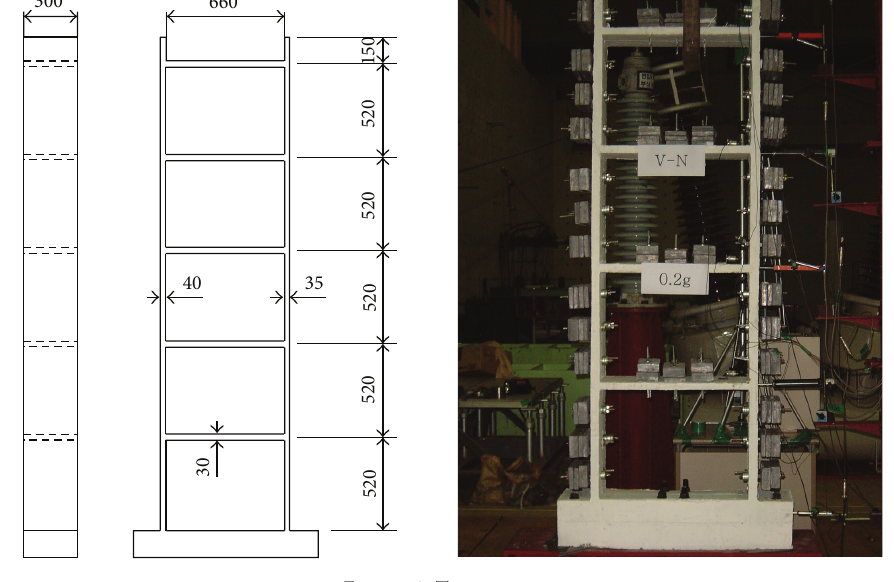
Figure 3: Test structure.